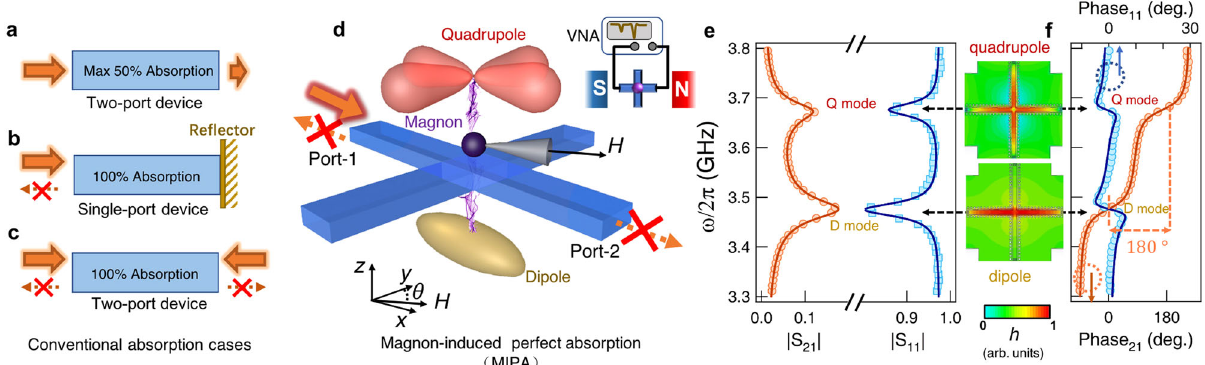
Fig. 1 A sketch of MIPA. a Schematic diagram of the electromagnetic absorption limitation (50%) in a symmetric two-port system. b Perfect electromagnetic absorption of a single-port system under the critical coupling condition. c Schematic diagram of the coherent perfect absorption (CPA) strategy that utilizes the interference of two coherent counter-propagating beams. d A schematic of MIPA. Two cavity photon modes in a cross cavity are coupled to a magnon mode in a YIG sphere. The bias magnetic fi eld H is applied in the x-y plane with an adjustable angle θ from y-axis. By utilizing the interference between hybrid photon-magnon modes, near-perfect absorption can be achieved. e Transmission and re fl ection spectra of the cross cavity show two distinct cavity photon modes, i.e., D- and Q-modes (labeled near their resonances). Symbols and solid lines show experimental and calculated results, respectively. f Phase information of these two modes. They are out of phase in the transmission but in phase in the re fl ection. The two insets between ( e ) and ( f ) are numerical simulations of the radio frequency magnetic fi eld ( h ) distributions for D- and